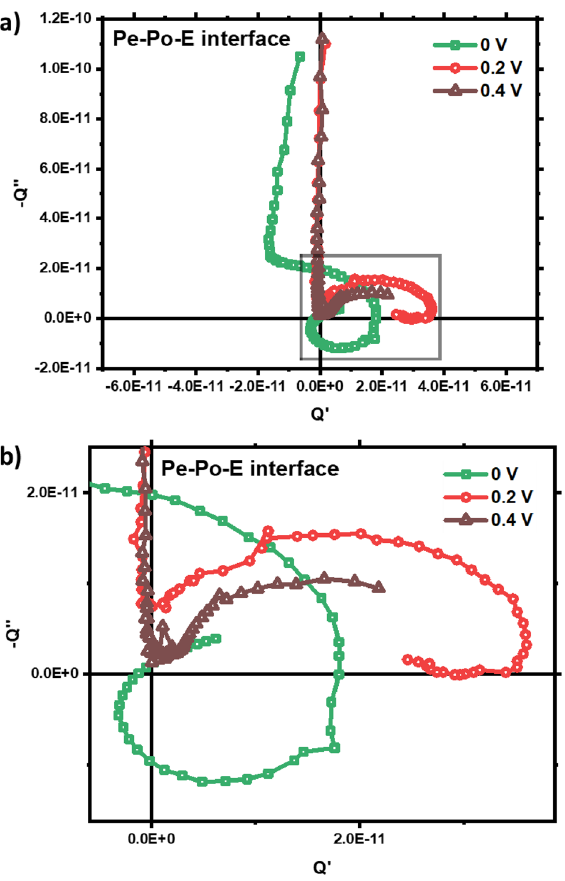
Figure 4. ( a ) IMPS Spectra of perovskite–polymer–electrolyte interface device at different applied bias (0, 0.2, 0.4 V), ( b ) zoomed view of the corresponding low-frequency